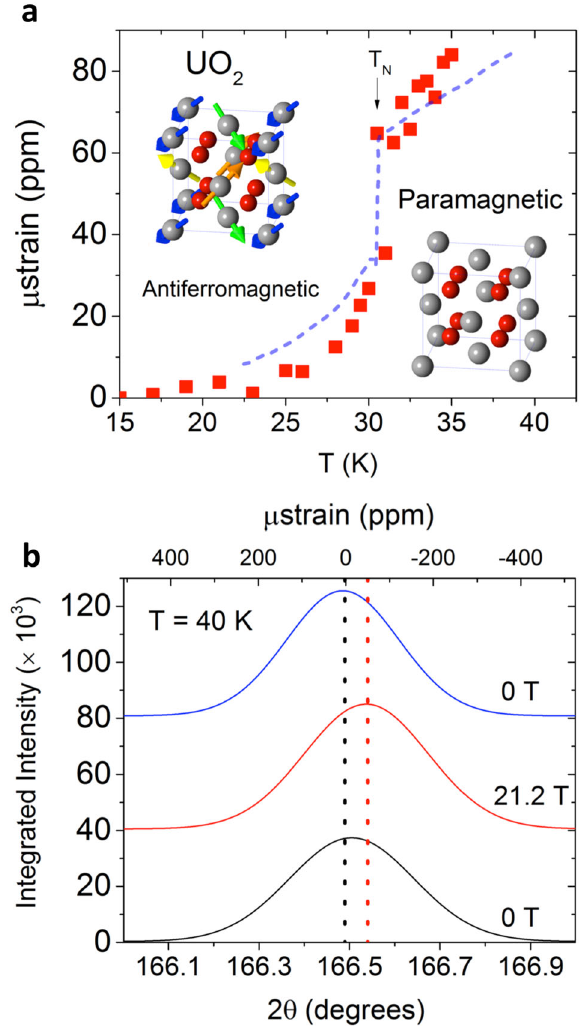
Fig. 1 Thermal expansion and magnetostriction in the paramagnetic state of UO 2 . a The relative change of the lattice constant in the <111> direction of the UO 2 single crystal as a function of temperature, measured by dilatometry of the bulk crystal (dashed line) and X-ray diffraction of the [888] peak (red squares). The X-ray data were obtained by single crystal diffraction in high-angle back-re fl ection geometry using 15.85 keV X-rays. An abrupt collapse in unit cell volume can be seen at T N = 30.8 K, marked by an arrow. Insets show the structure of the UO 2 cubic unit cell above T N (paramagnetic phase) and below T N (ordered phase). b The magnetic response of the [888] peak in the paramagnetic phase ( T = 40 K) to an applied pulsed magnetic fi eld in the <111> direction. The initial state at 0 T (black line) shifts to higher 2 θ at maximum applied fi eld of 21.2 T (red line), then back to the same initial value after the pulse (blue line). The shift in 2 θ of the peak corresponds to a small ~50 p.p.m. strain contraction in the <111> direction, consistent with bulk single crystal magnetostriction measurements 2